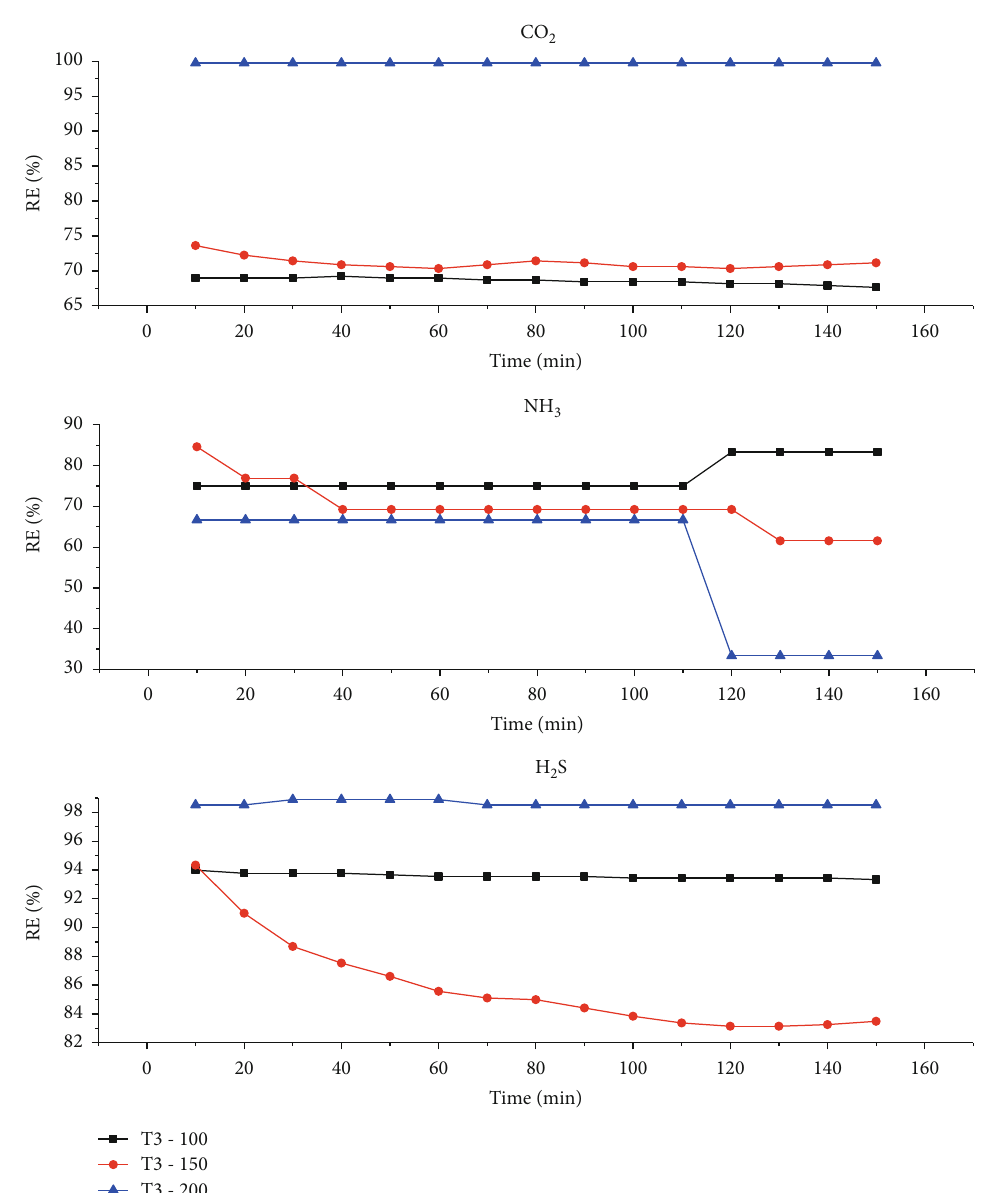
= 100 g, m = 150 g, m = 200 g, P = 10 kPa, C 1 2 3